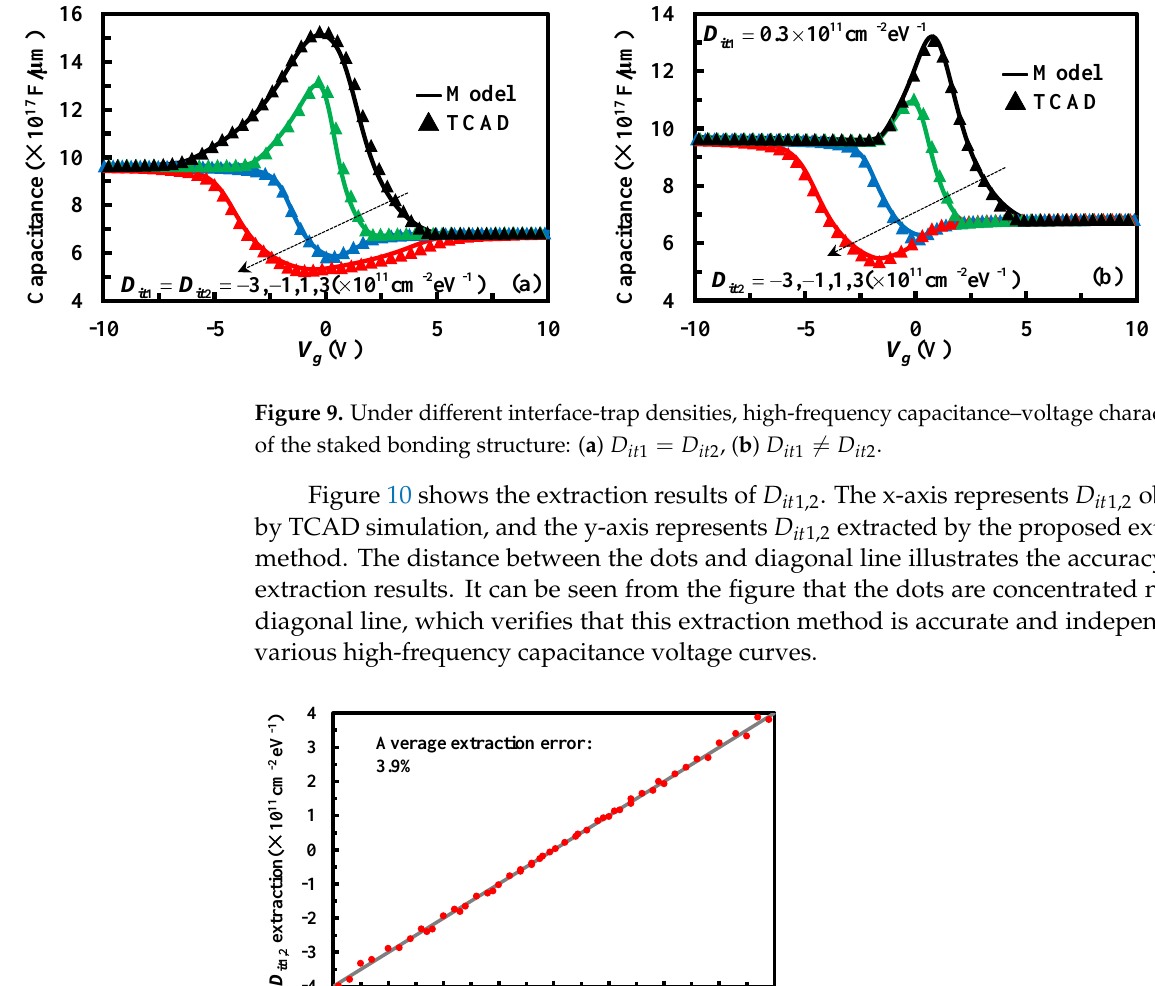
Figure 10. D it 1,2 target and extraction using the proposed extraction method.